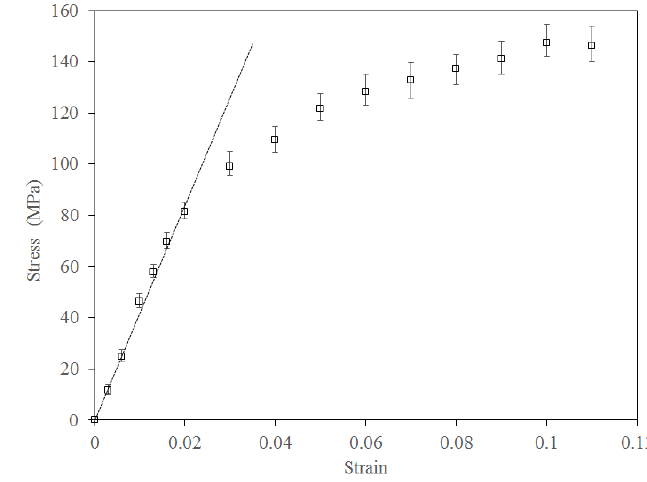
Figure 13. Stress-strain curve of FPCB for reflow.